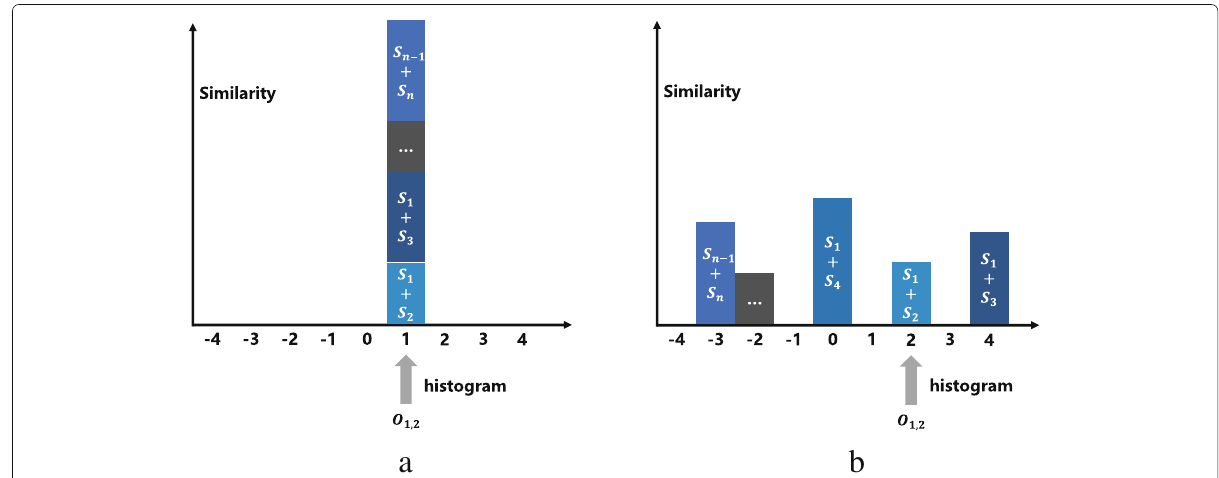
Fig. 3 Similarity histograms, showing similarity distributions based on the OPR. a same OPR. b different